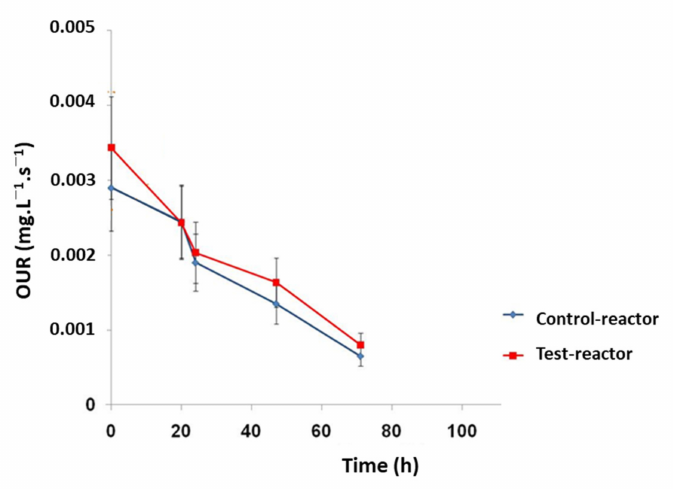
Figure 2. OUR TBT and OUR control evolution over time in the test and control